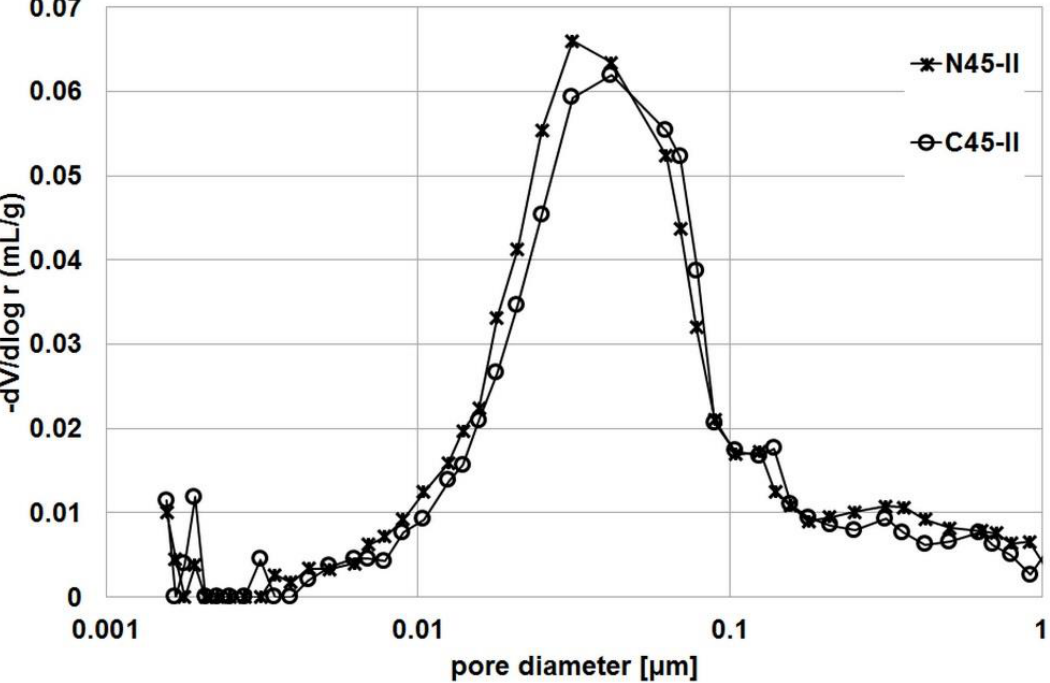
Figure 6. Pore distribution in R45-II series.